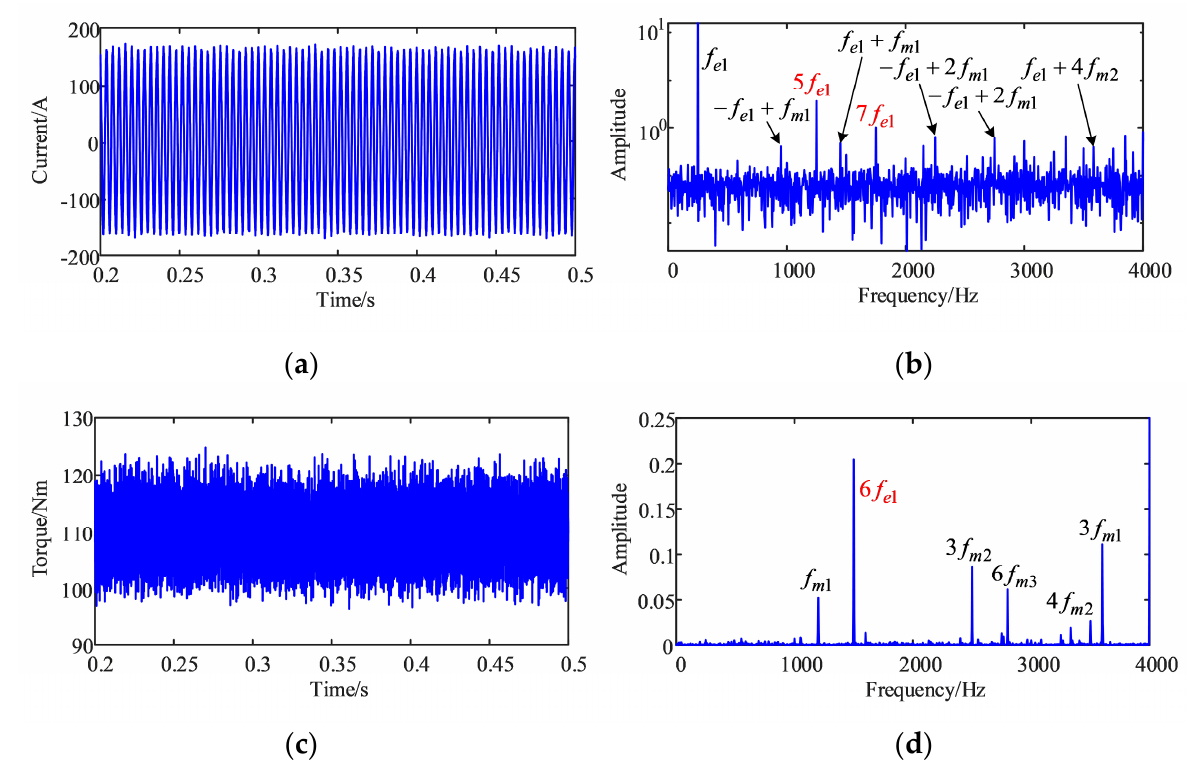
Figure 10. Electrical system vibration response: ( a ) current time domain; ( b ) current frequency domain; ( c ) electromagnetic torque time domain; ( d ) electromagnetic torque PSD.